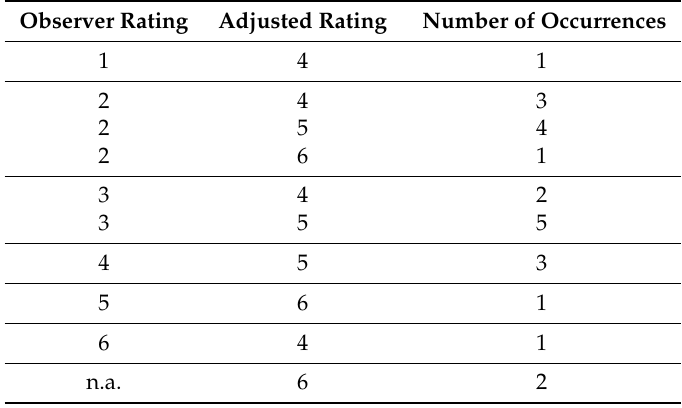
Table 3. Adjustment of observer ratings after integration of detected micro-sleep events with number of occurrences for each case; n.a.: no observer rating available.